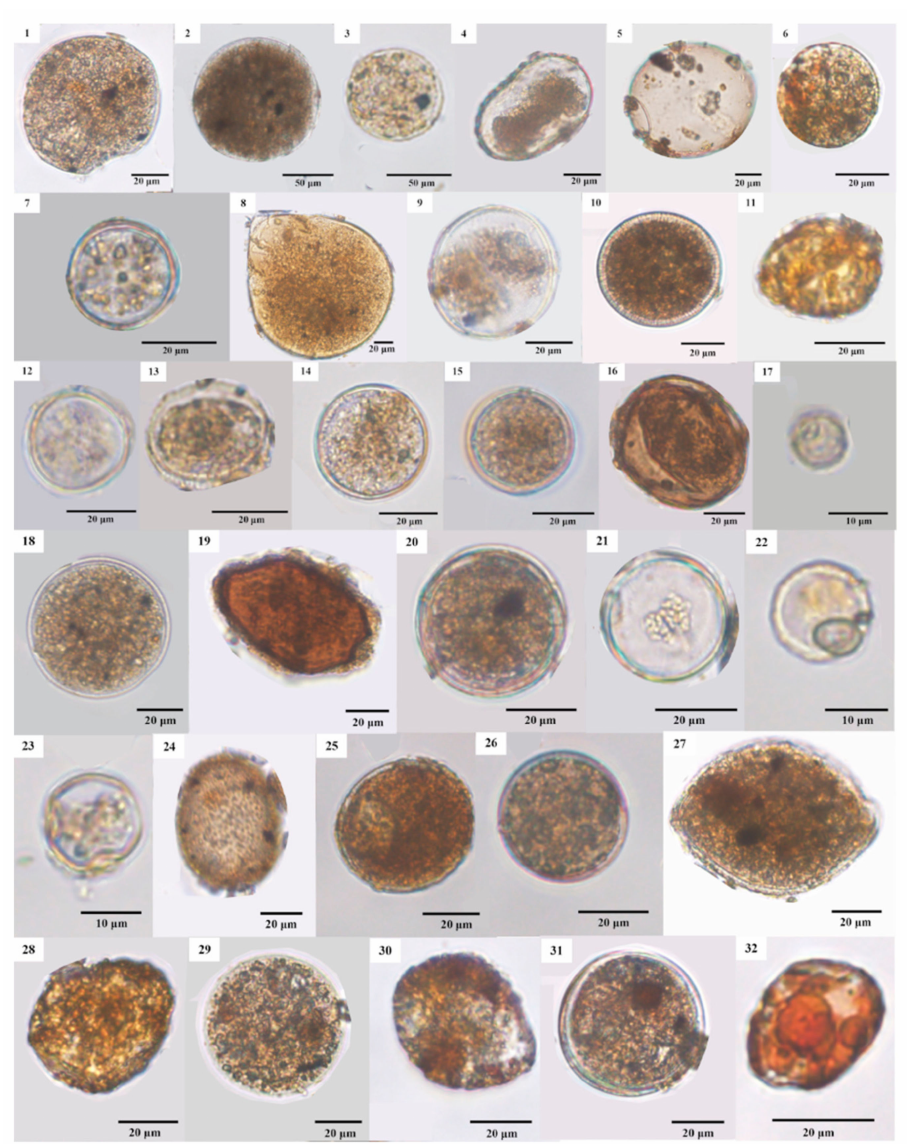
Figure 2. Light microscopic micrographs of cysts from Sample 9055. Except for Protoperidinium sp. (5), Alexandrium sp. (7, 15 and 22), and Scrippsiella sp. (24), all other cysts were not convincingly identified due to the absence of both identification references and diagnostic